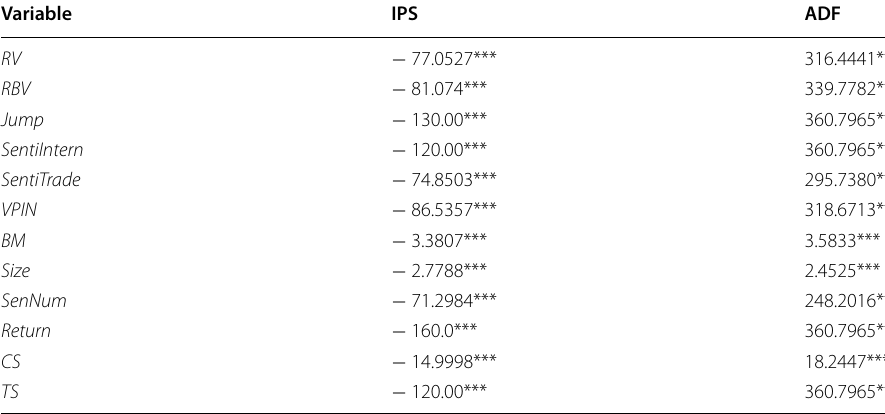
Table 4 The unit root testing results